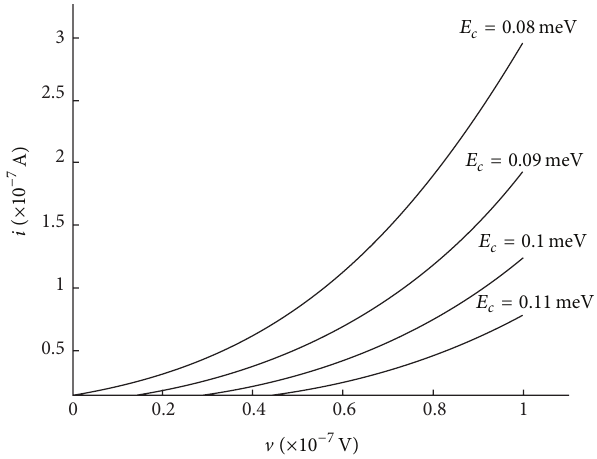
Figure 6: InO 𝑥 film 𝐼 - 𝑉 curves for three values of the Josephson junction-charging energy 𝐸 𝑐 . The change in 𝐸 𝑐 is brought about by the space charge of the displaced In and O ions (recoils) which become interstitials in the irradiated